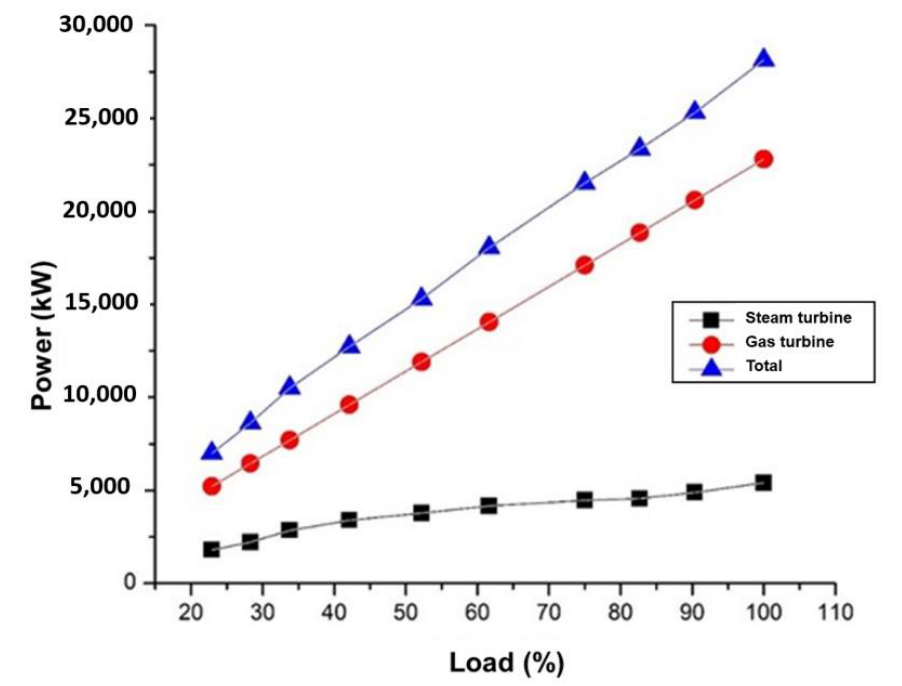
Figure 7. Power to the loading of the propulsion system.